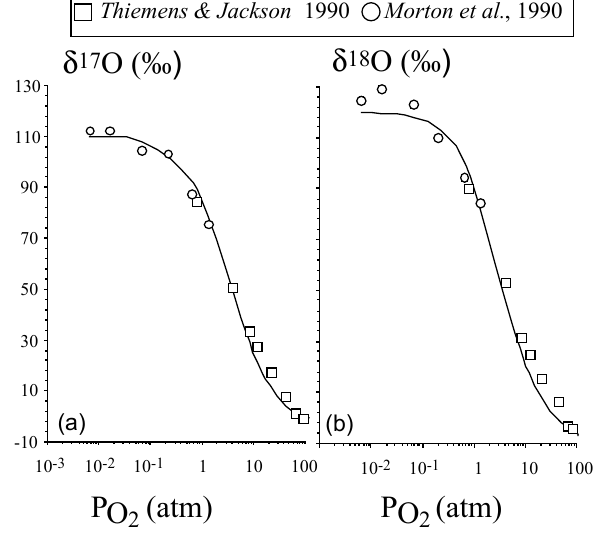
Fig. 6. Calculated variations (solid lines) of (a) δ 17 O(‰) and (b)